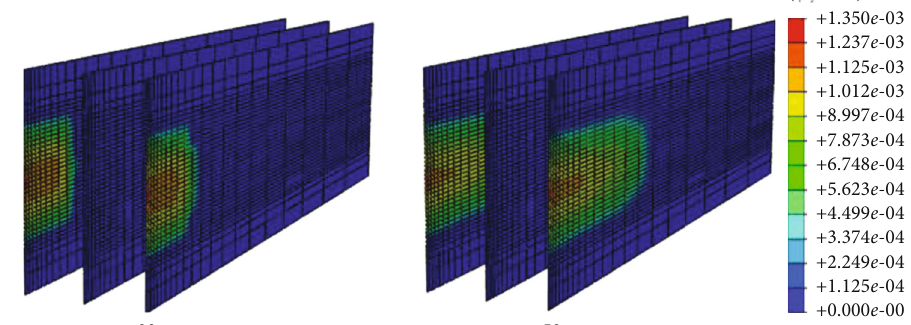
Figure 6: Fracture geometry after pumping for 20s and 50 s in case 2.